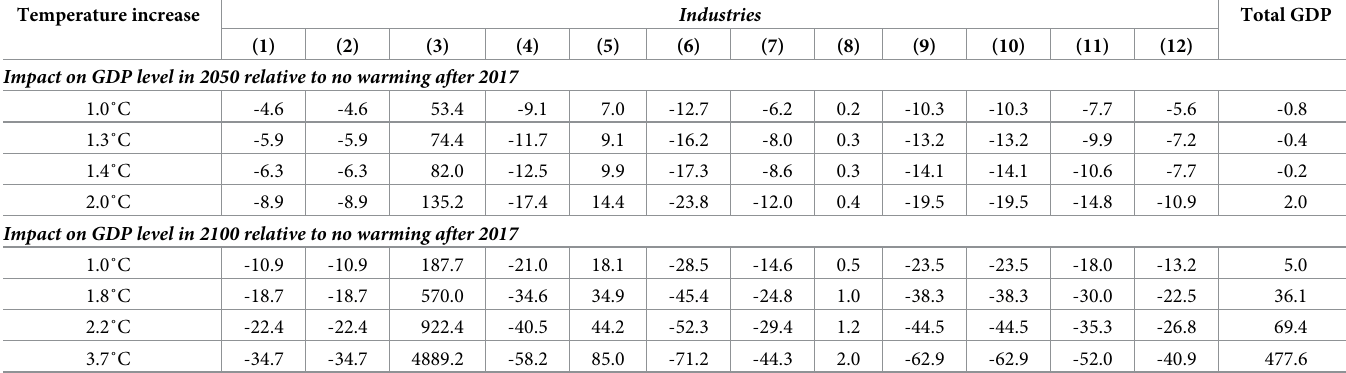
may decline between 18.7% and 33.9% in 2050, relative to a scenario with no additional climate change. Construction, Financial services and Home property would decline between 10.3% and 23.8% in 2050 due to the impact of worsening climate change. In terms of the total GDP, the effect of climate change in 2050 would imply a deterioration between 6.8% and 12.9%. By 2100 the Agriculture and Fishing industries would decline between 40% and 84.9%, while the Construction, Financial services and Home property would decline between 23.5% and 71.2% due to climate change. Climate change by 2100 could imply a deterioration between 15.5% and 42.3% on the total Chilean GDP.